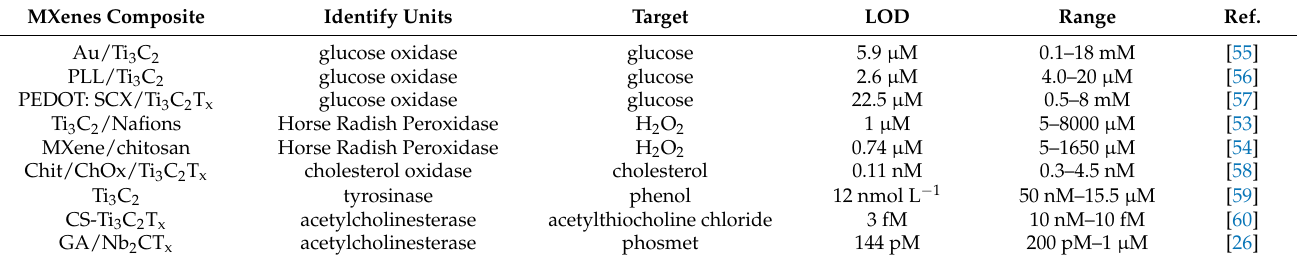
Table 1. Enzyme-based electrochemical biosensors for identifying units, target, and analytical Table 1. Enzyme − based electrochemical biosensors for identifying units, target, and analytical pa- rameters.